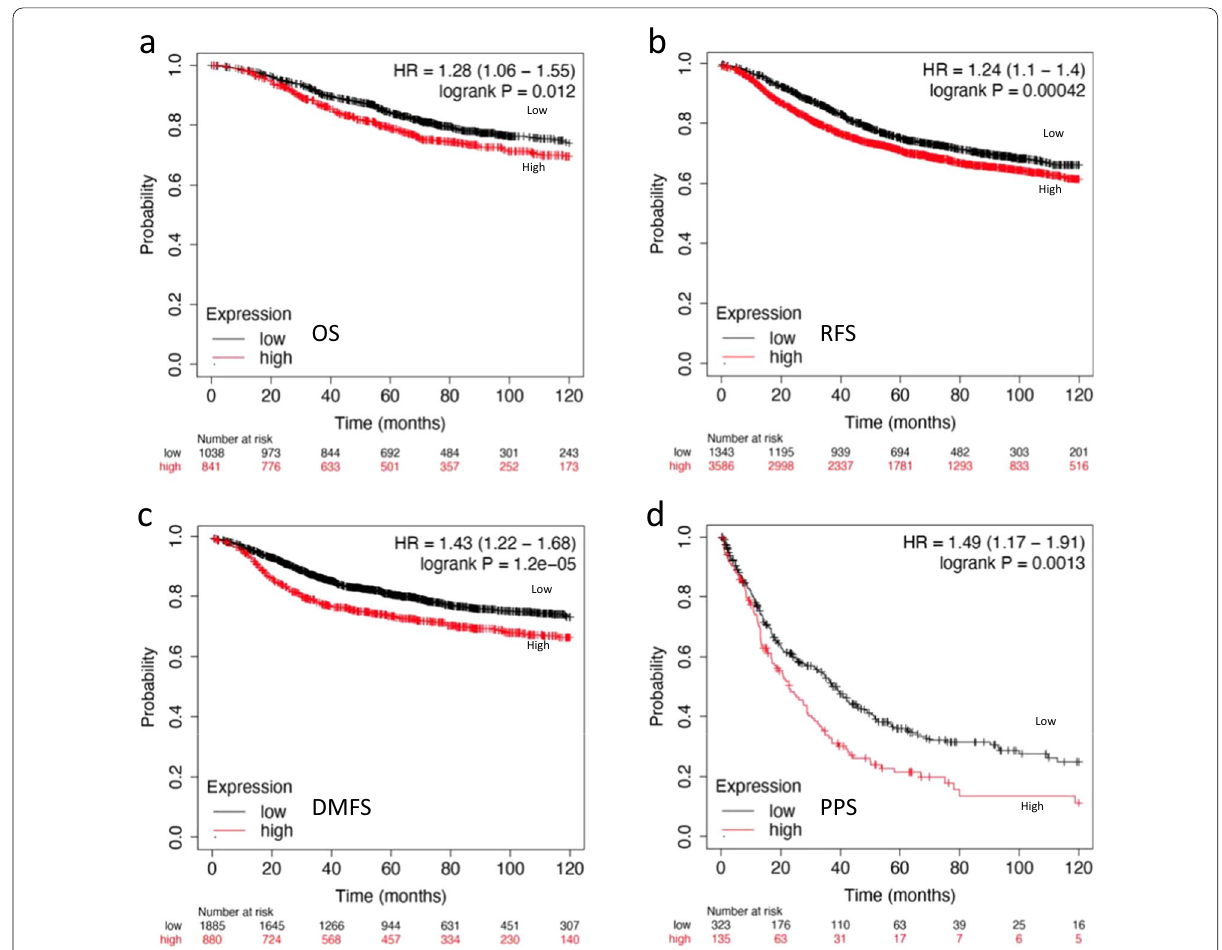
Fig. 7 The clinical relevance of NDR1. a – d Kaplan–Meier analysis and the log‑rank test were performed to evaluate the correlation between NDR1 expression and